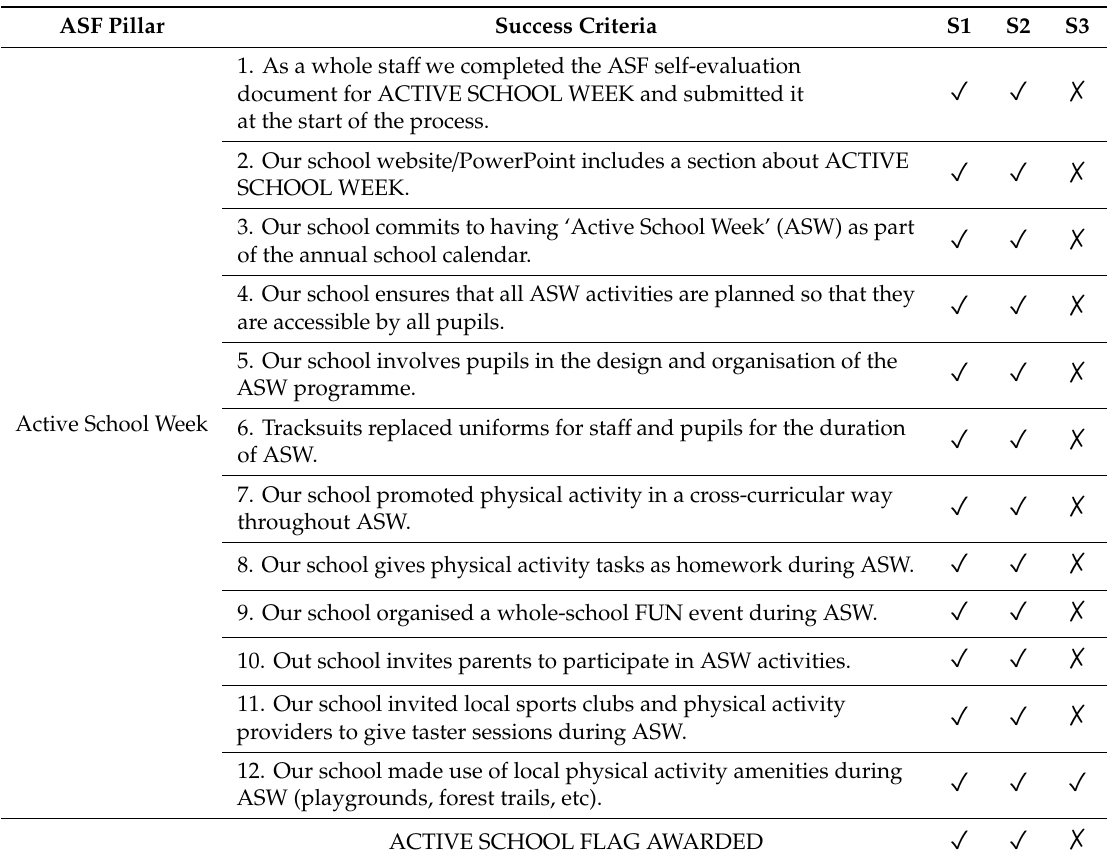
Table 2. ASF success criteria achieved by each case study school.